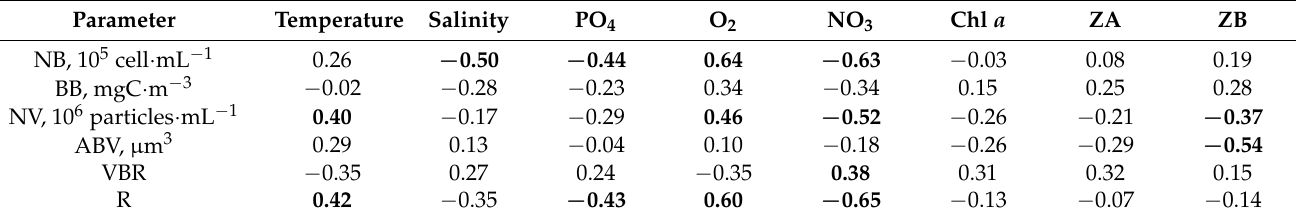
Table 4. Pearson’s correlation coefficients between environmental parameters and microbial variables in the northeastern Barents Sea, in autumn